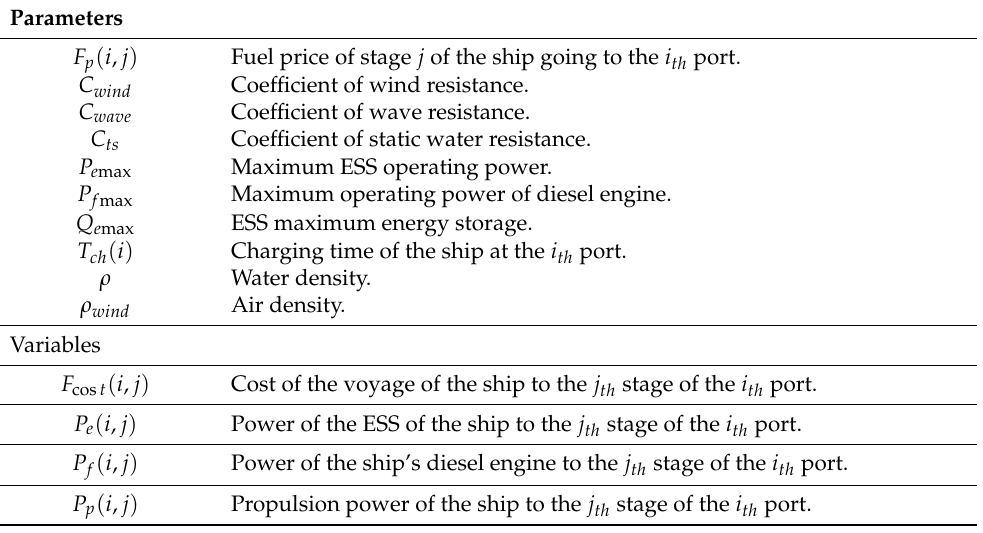
Table 2. Energy management variables and